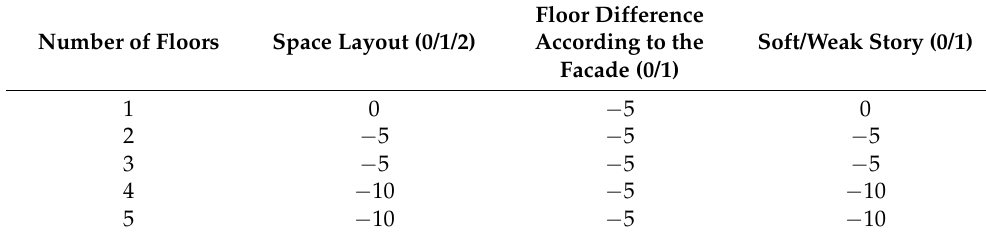
Table 11. Vertical negativity scores (PDRB-2019).